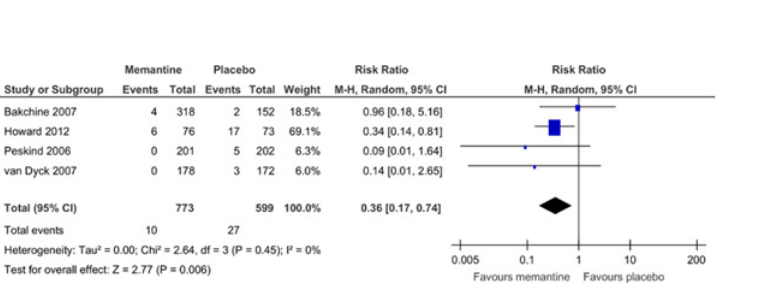
Fig 9. Forest plot of discontinuation due to adverse events (7 studies, n = 2371). * Negative SMD values favor memantine; positive SMD values favor placebo. † RR < 1 favors memantine; RR > 1 favors placebo.